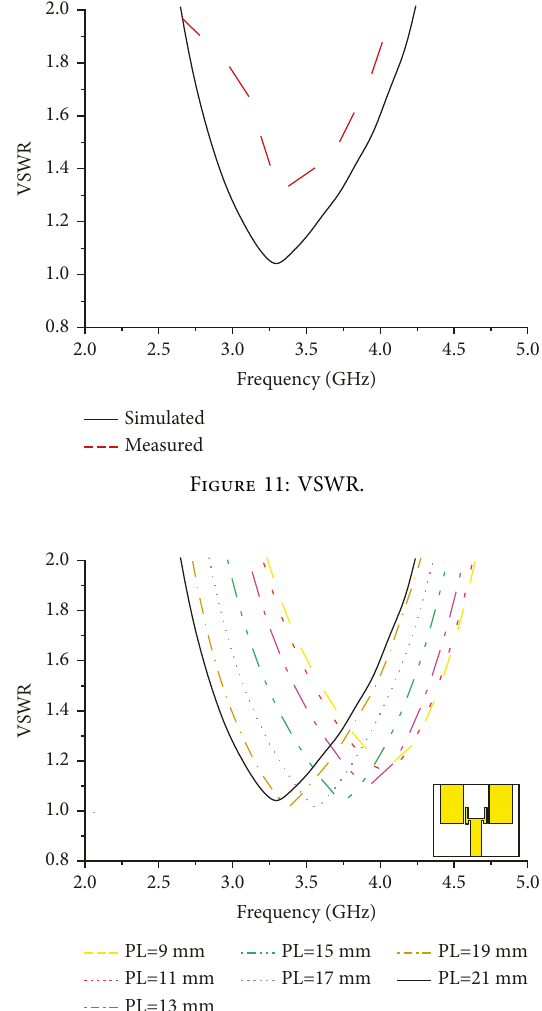
Figure 12: Variation of the VSWR for different length of parasitic element on the ground plane ( P